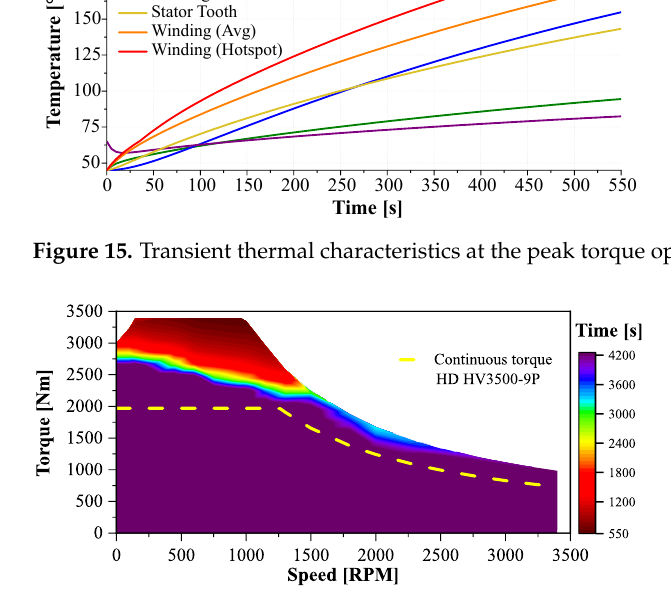
Figure 16. Transient overheating time for 36/24 ERCV